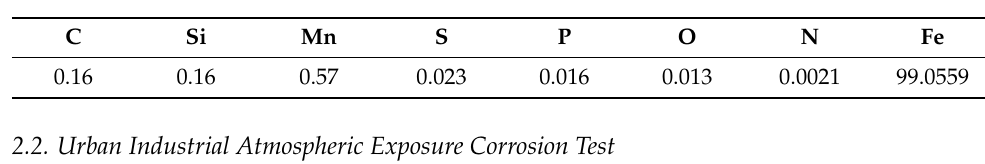
Table 1. The chemical compositions of Q235B steel (mass in